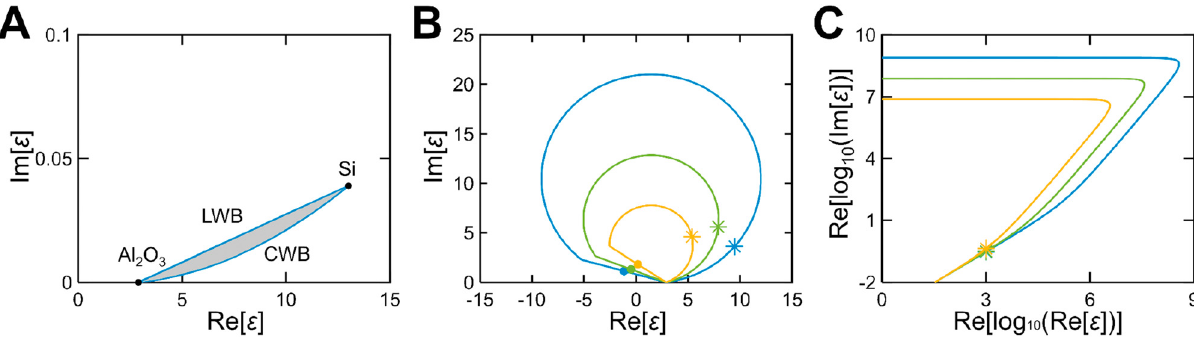
Figure 2: Wiener bounds of various composite materials. (A) Wiener bounds of a composite of two dielectric materials. Amorphous Al 2 O 3 and crystalline Si near 800 nm wavelength are assumed. Effective permittivity can be realized only within the boundary between Circular Wiener Bound(CWB) andLinear Wiener Bound (LWB) (shadedregion).(B) Wiener bounds of a compositematerial mixture of amorphousAl 2 O 3 andAu at 500 nm (yellow), 520 nm (green), 540 nm (blue) wavelengths. Filled dots and asterisks are algebraic averages and harmonic averages of permittivities of Al 2 O 3 and Au for the same volume ratio, respectively. (C) Wiener bounds of a composite material composed of gold and a model dielectric at 1, 10, 100 GHz frequencies (blue, green, yellow, respectively). For permittivity of a dielectric, 10 + 0.003 i is assumed for all frequencies. Asterisks indicate harmonic averages of the conductor and the dielectric when volume fraction of the dielectric is 0.01, respectively. Homogenized permittivity based on the harmonic average (i.e. ε eff ≈ 100 ε d ) is nearly